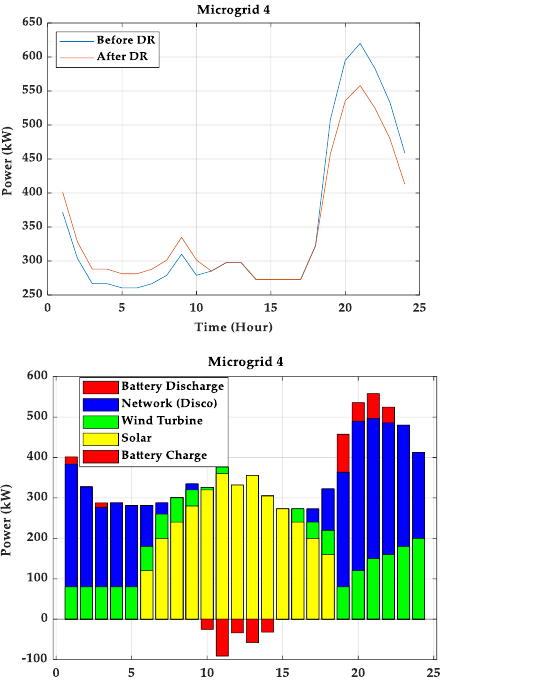
Figure 18. DR curve for MG 3.